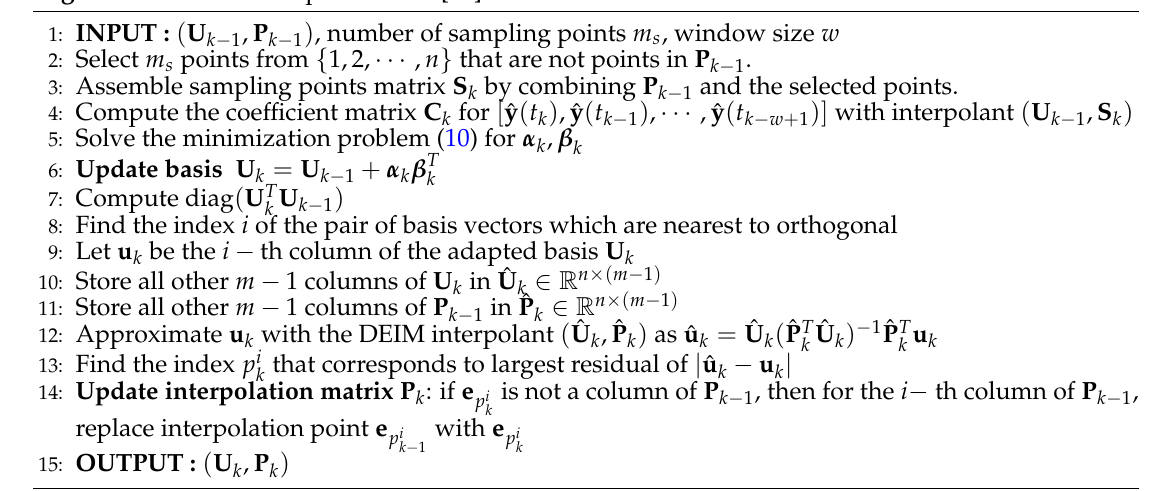
Algorithm 2 Online Adaptive DEIM